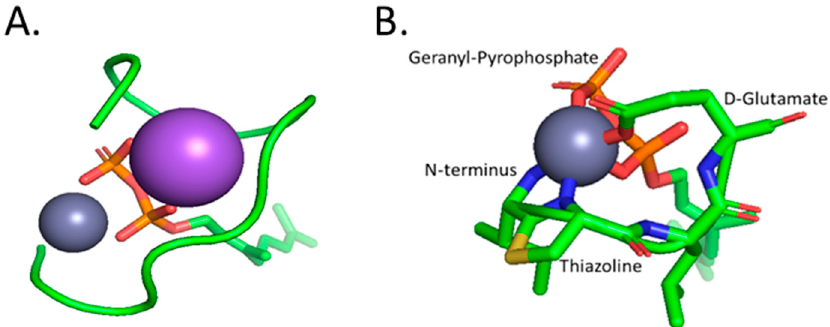
Figure 3. ( A ) The full complex of Zinc coordination with the geranyl-pyrophosphate ligand, represented in red (oxygen), orange (phosphorus), and green for the geranyl chain, and bacitracin displayed in a green ribbon representation. Sodium and Zinc are represented as the large purple sphere and small grey sphere, respectively. The sodium ion found within the complex is thought to neutralize the pyrophosphate charge and bridge oxygen atoms from the pyrophosphate and C-terminal of Bacitracin. ( B ) A zoomed-in depiction of the inner-sphere coordination of Zinc with the N-terminal amine, amino acids, D-Glu4 and thiazoline, oxygens from the geranyl-pyrophosphate, and an unrepresented water molecule. All structures were generated in PyMOL [52].